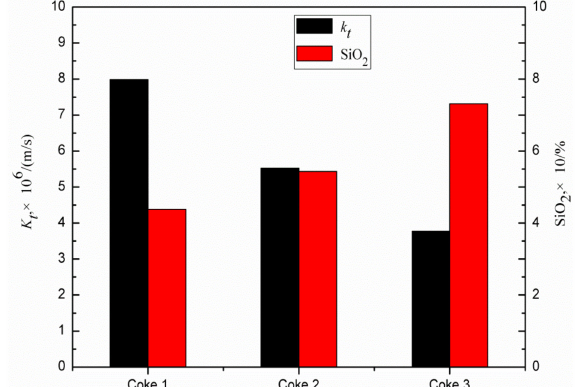
Figure 9. E ff ect of silicon content in the iron-carbon bath on k t Metals 2019 , 9 , x FOR PEER REVIEW